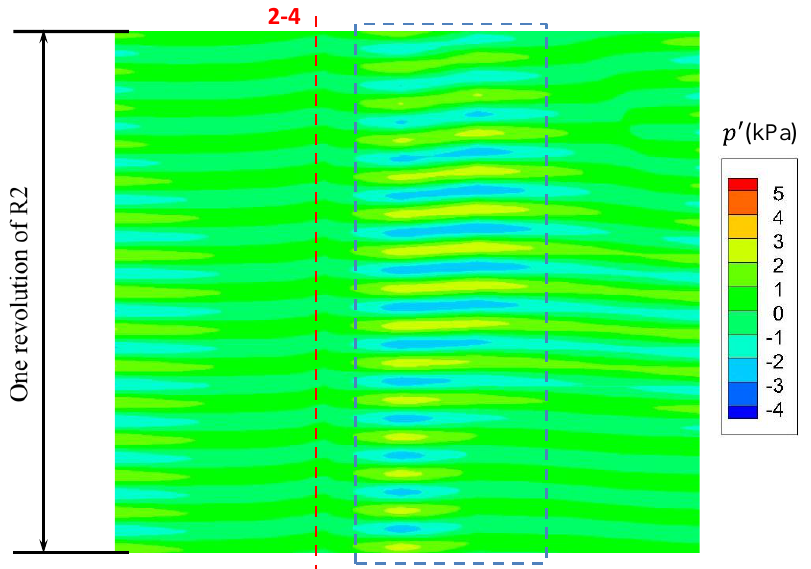
Figure 8. The propagation of the R1-1BPF disturbance within the R2 passage.